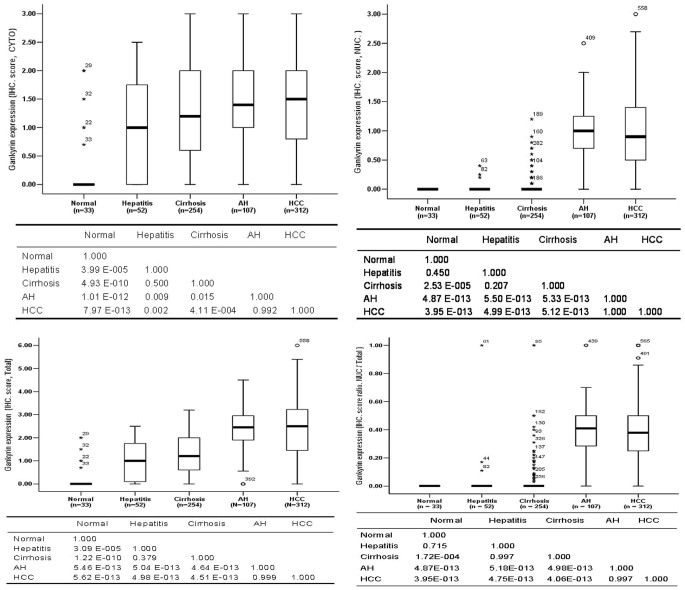
Boxplot of the immunostaining scores for Gankyrin in the cytoplasm, nucleus, whole cell, and nuclear expression vs. total expression ratio in the normal liver, hepatitis, cirrhosis, AH, and HCC specimens utilized in this study.A statistical analysis of Gankyrin expression was performed, with the P-value for the difference among the experimental groups shown (bottom parts).